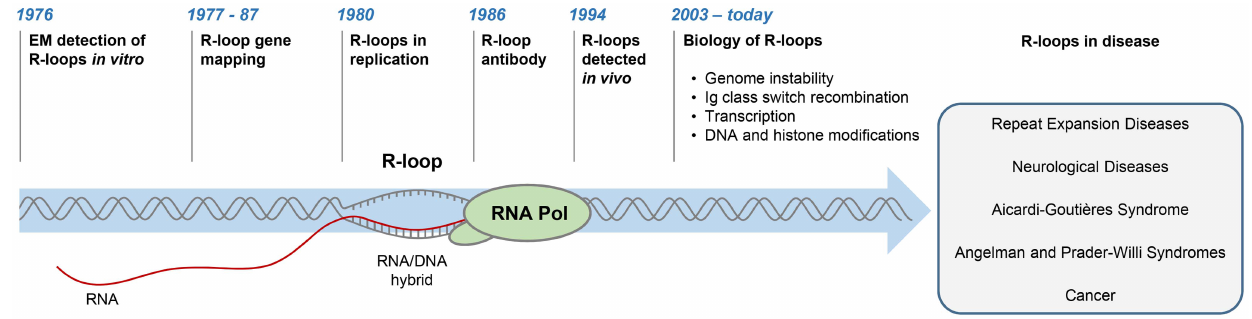
Figure 1. History of R-loop research. The diagram depicts major developments in the R-loop field and diseases associated with R-loop dysregulation.